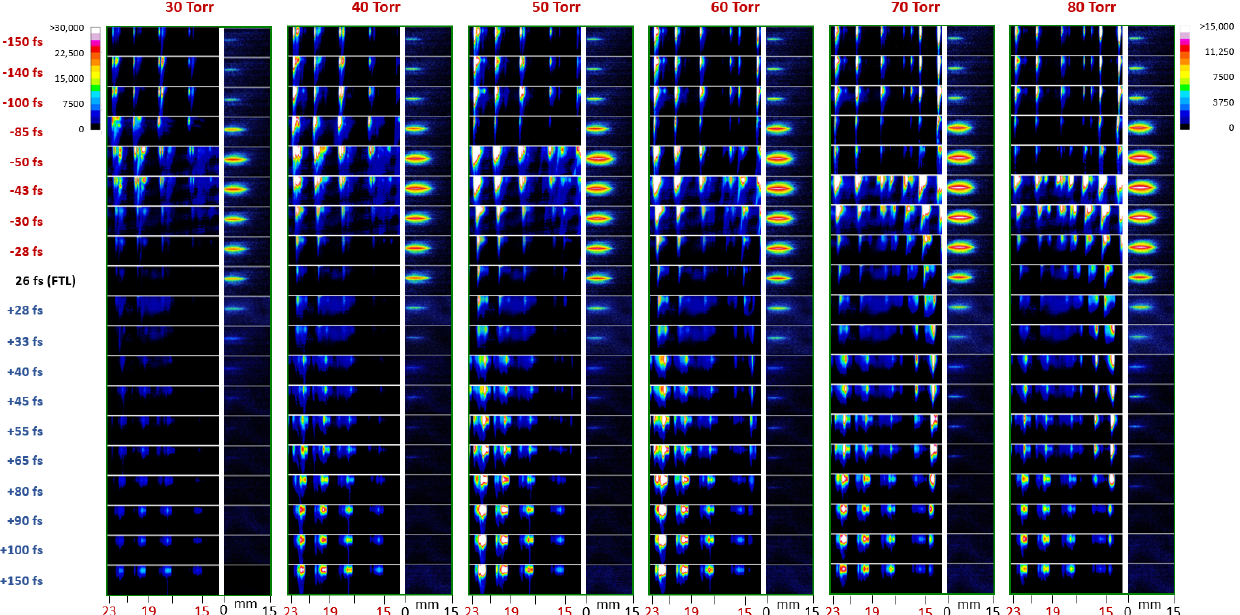
Figure 3. Same as in Figure 2, except that the focus of the laser beam is 3 mm before the exit pinhole of the semi-infinite